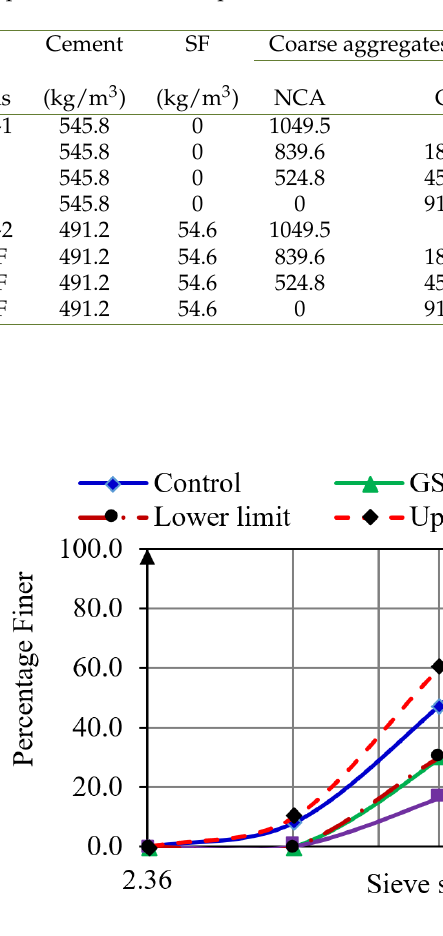
Fig. 2. Size distribution of coarse